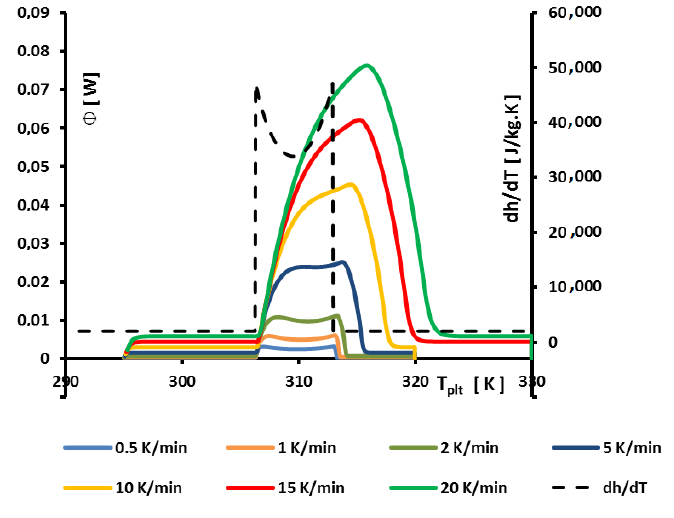
d h for a solution at x 0 = 0.5; from d T